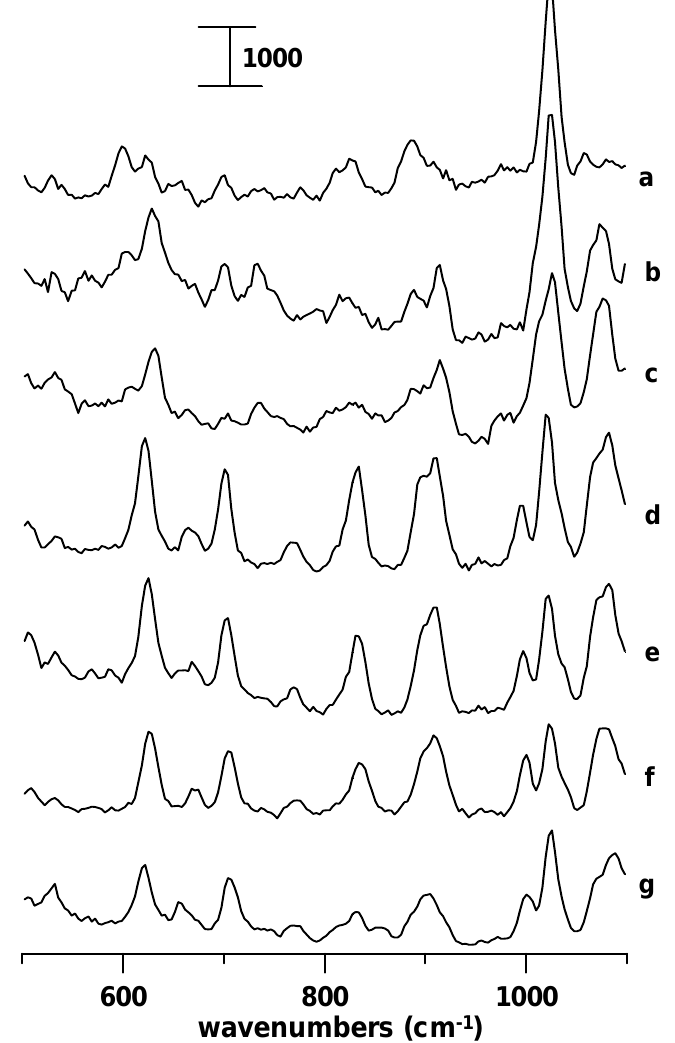
Figure 3. Raman spectra of 1-butyl-3-methylimidazolium chloride in a supercooled state under